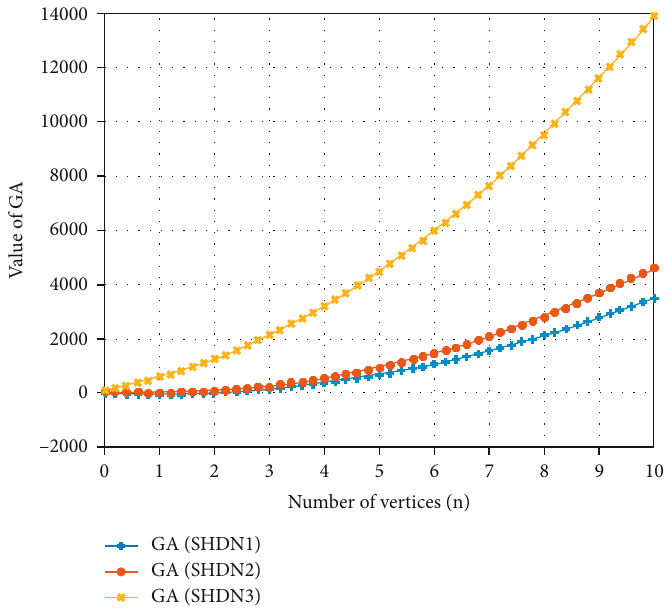
n Þ , Γ n Þ , and Γ n Þ using 2D graphs of GA 1 ð 2 ð 3 ð